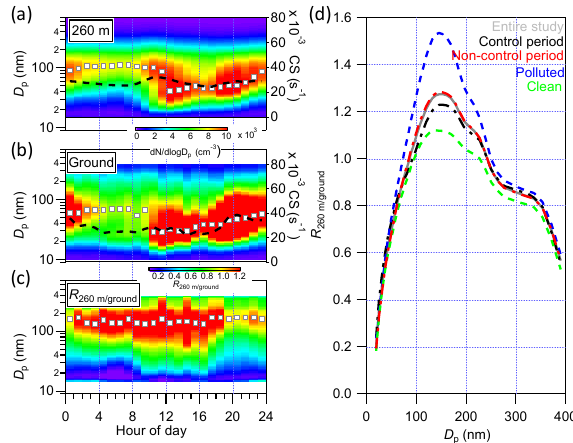
Figure 5. Average diurnal variations in particle number size distri- butions at (a) 260m and (b) ground level and (c) the ratios of 260m to ground level for the entire study. Panel (d) shows the ratios of particle number concentrations at 260m to those at ground level as functions of particle